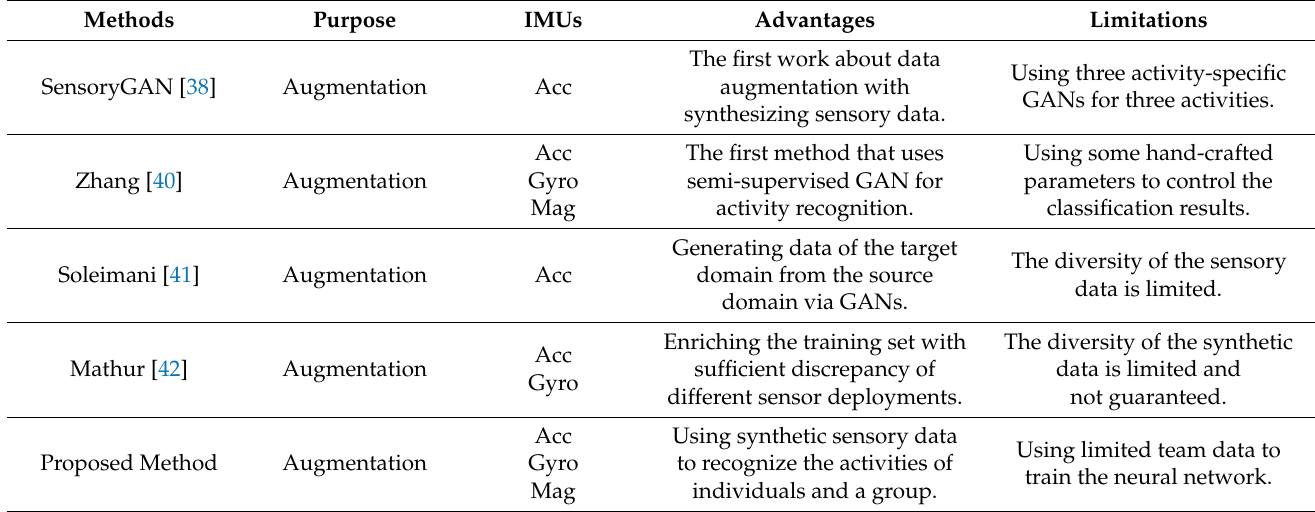
Table 1. The comparison of different sensory methods using for HAR with GAN model.